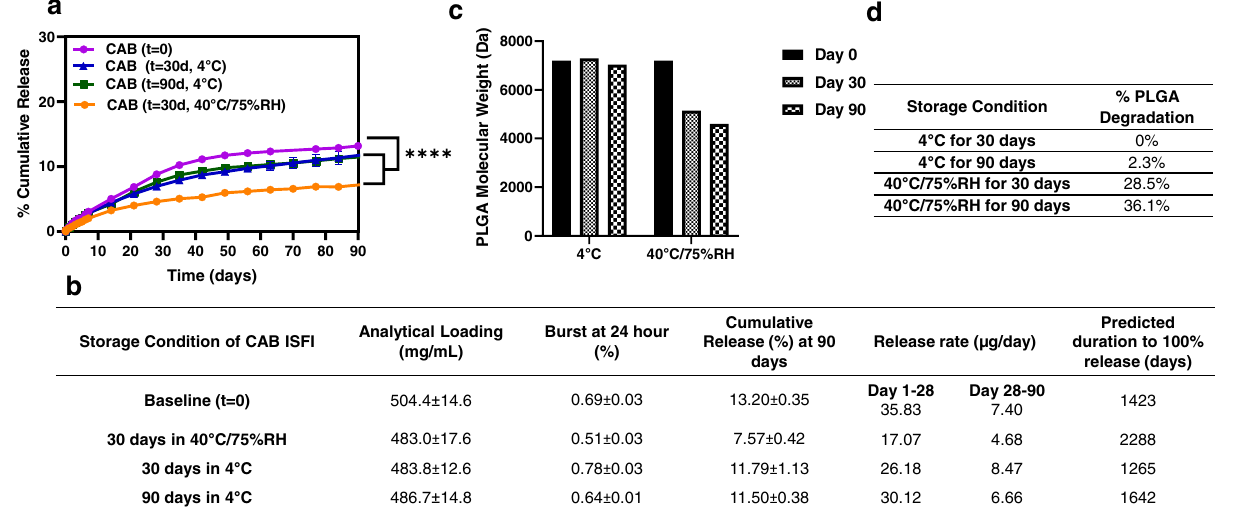
post-storage in vitro release, all storage formulations elicited CAB release sig- ni fi cantly different and slower than baseline ( p <0.0001) b Summary table of CAB ISFI post-storage in vitro release kinetics from a . c Effect of storage conditions on PLGA weight average MW of placebo formulations measured by gel permeation chromatography (GPC) analysis. d Summary table of PLGA degradation in placebo formulation after 30 and 90 days at 4°C and 40°C/75% RH. Solvent=1:1 w/w NMP:DMSO. Source data are provided as a Source Data fi